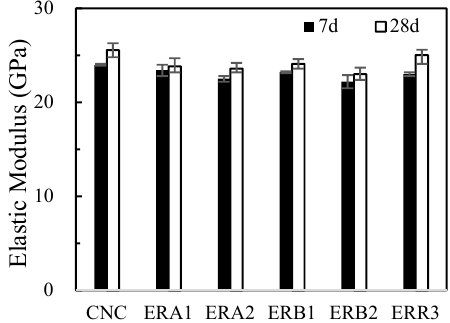
Figure 7. Young’s modulus results of concrete samples.